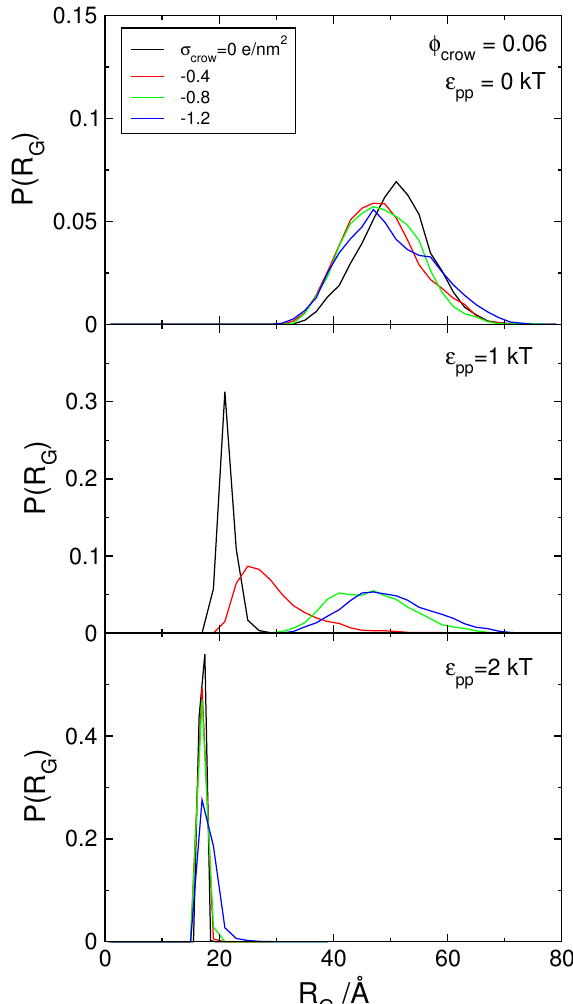
Figure 6. Probability distribution of the radius of gyration, P ( R G ) , of the polyion in the presence of model protein dimers with attractive potentials varying between ε pp = 0 and 2 kT, in the presence of crowding molecules ( Φ crow = 0.06) with increasing surface charge density, as